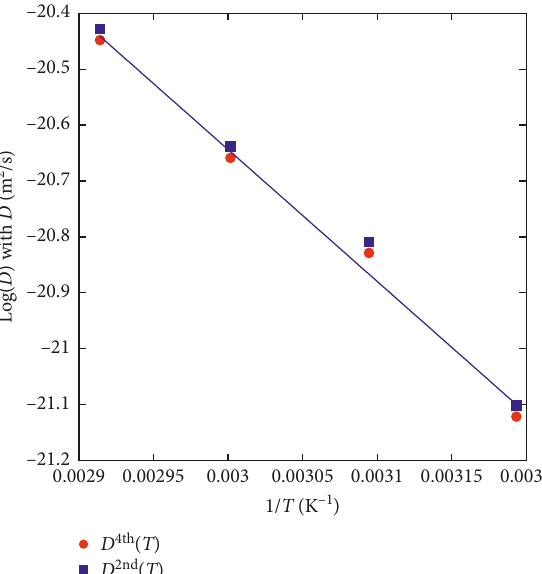
Figure 7: Estimated diffusivities D 2nd represents the Arrhenius correlation function D